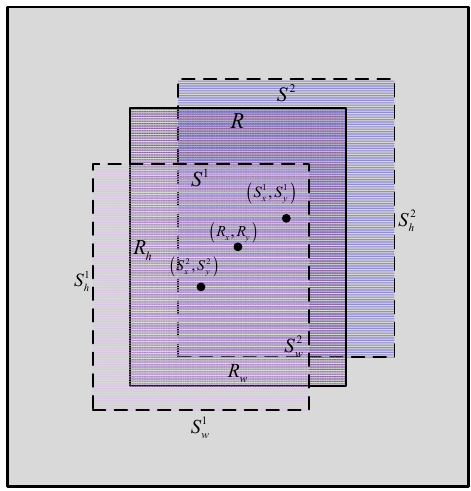
Figure 8. The relationship between the sampled box S and the real box R . After training the regressor by the mapping function from a real bounding box to the sampled bounding boxes. A predicted bounding box can be generated by the regressor in the testing stage.